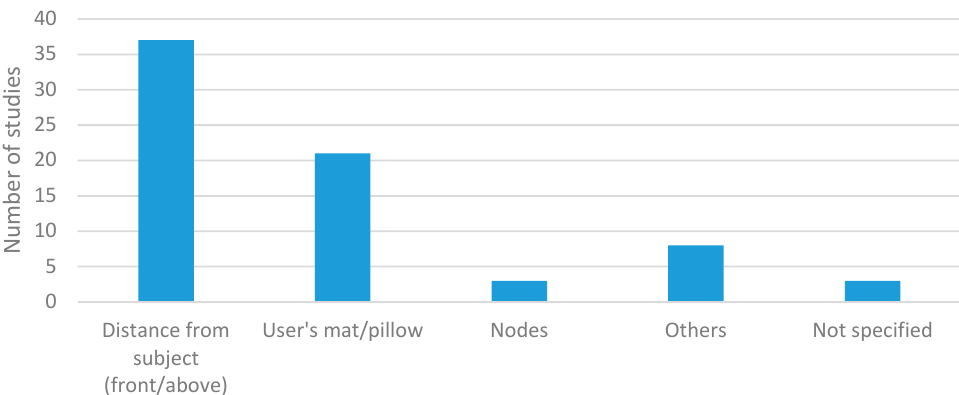
Figure 9. Distribution of sensor location for the wearable studies.